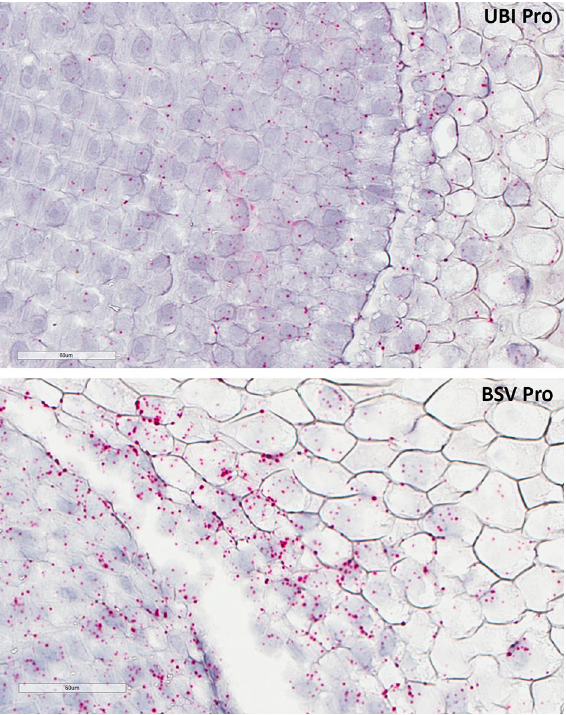
Figure 2. Visualization of DvSSJ1 transcript in the transgenic root tips. Transgenic root samples were collected at the V6 stage in the greenhouse and hybridized with DvSSJ1 probe. Single red dot presents one DvSSJ1 transcript in the root cell. Scale bar = 60